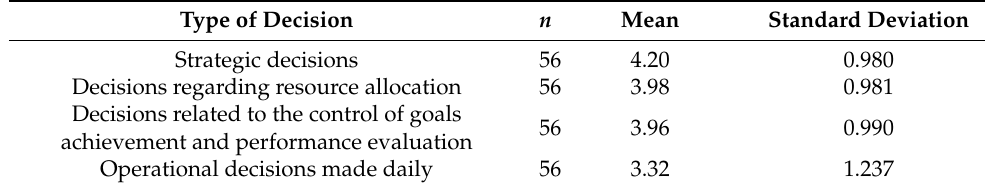
Table 3. AI importance by type of decision.